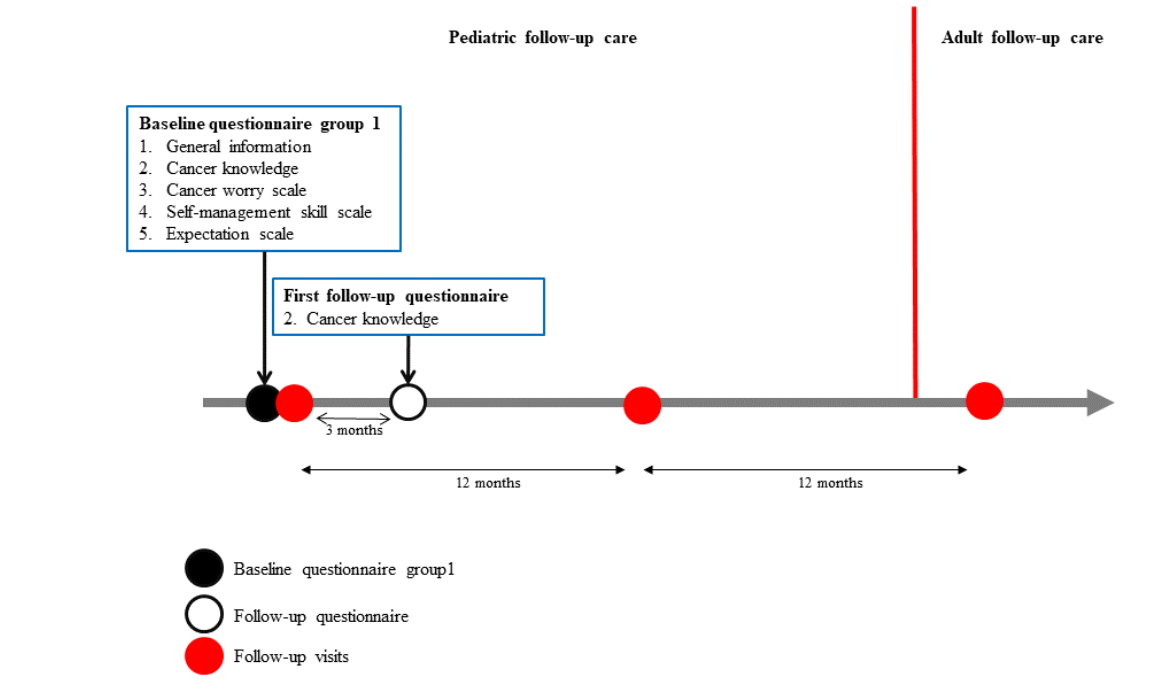
Figure 2. Timeline of the Aftercare of Childhood Cancer Survivors (ACCS) study and time points where group 1b participants answer questionnaires; questionnaire sections are numbered and identical numbers correspond to identical